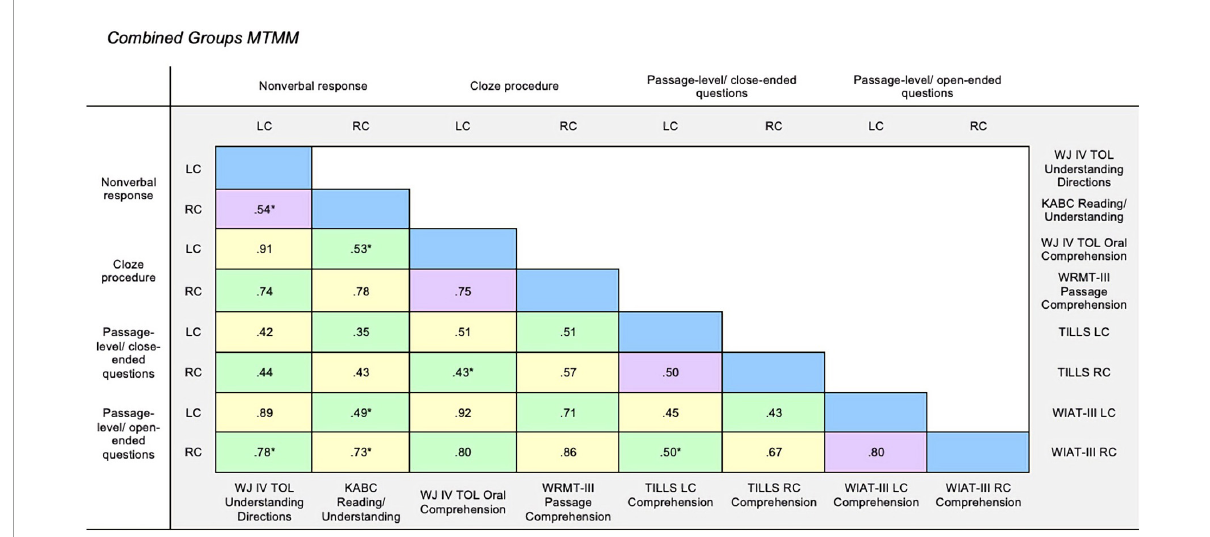
FIGURE3 Combined groups MTMM. Multitrait-multimethod matrix for Down syndrome group. Monotrait-monomethod cells (reliability diagonal) marked in blue, monotrait-heteromethod cells (validity diagonal) marked in yellow, heterotrait-monomethod cells marked in purple, and heterotrait-heteromethod cells marked in green. LC, Listening Comprehension; RC, Reading Comprehension; WJ IV TOL, Woodcock-Johnson Test of Oral Language IV (Schrank et al., 2014); KABC, Kaufman Assessment Battery for Children (Kaufman and Kaufman, 1983); WRMT-III, Woodcock Reading Mastery Tests-Third Edition (Woodcock, 2011); WIAT-III, Wechsler Individual Achievement Test-Third Edition (Wechsler, 2009). * p >